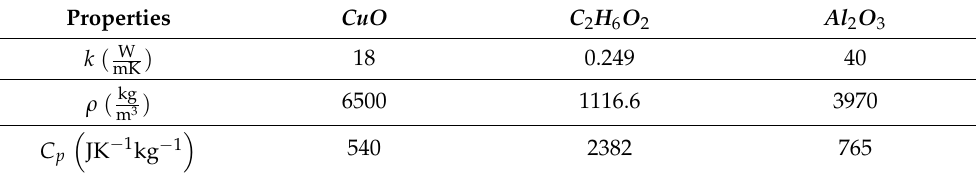
Table 2. Sphericity values for various shapes of the nanoparticles [17,19,36]. Sphericity Blade Platelet Cylinder Brick Sphere ψ 0.36